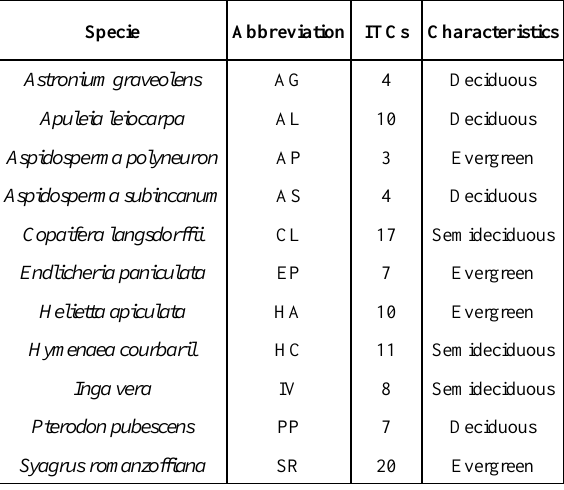
Table 1. Tree species and its number of samples identified in the study area